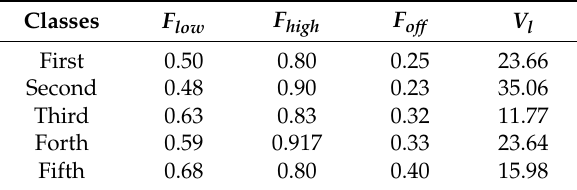
Table 9. Optimization results of control parameters.